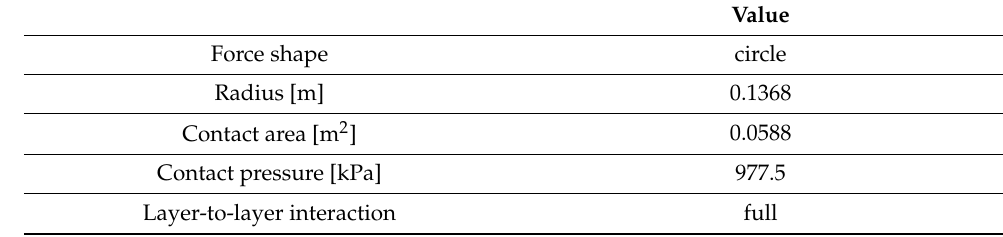
Table 4. General hints and assumptions used in FEM modeling.